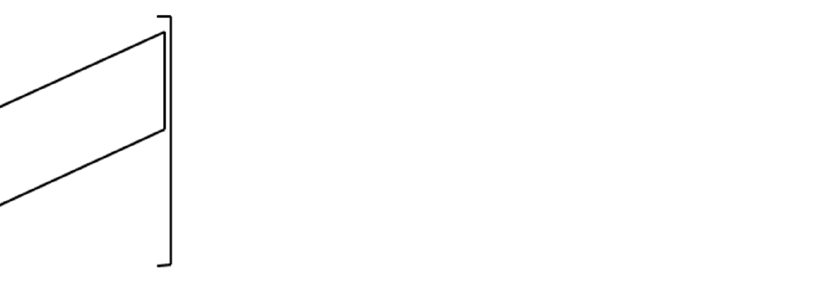
Figure 1. The structure of the computational structure called pseudo-band correlation.